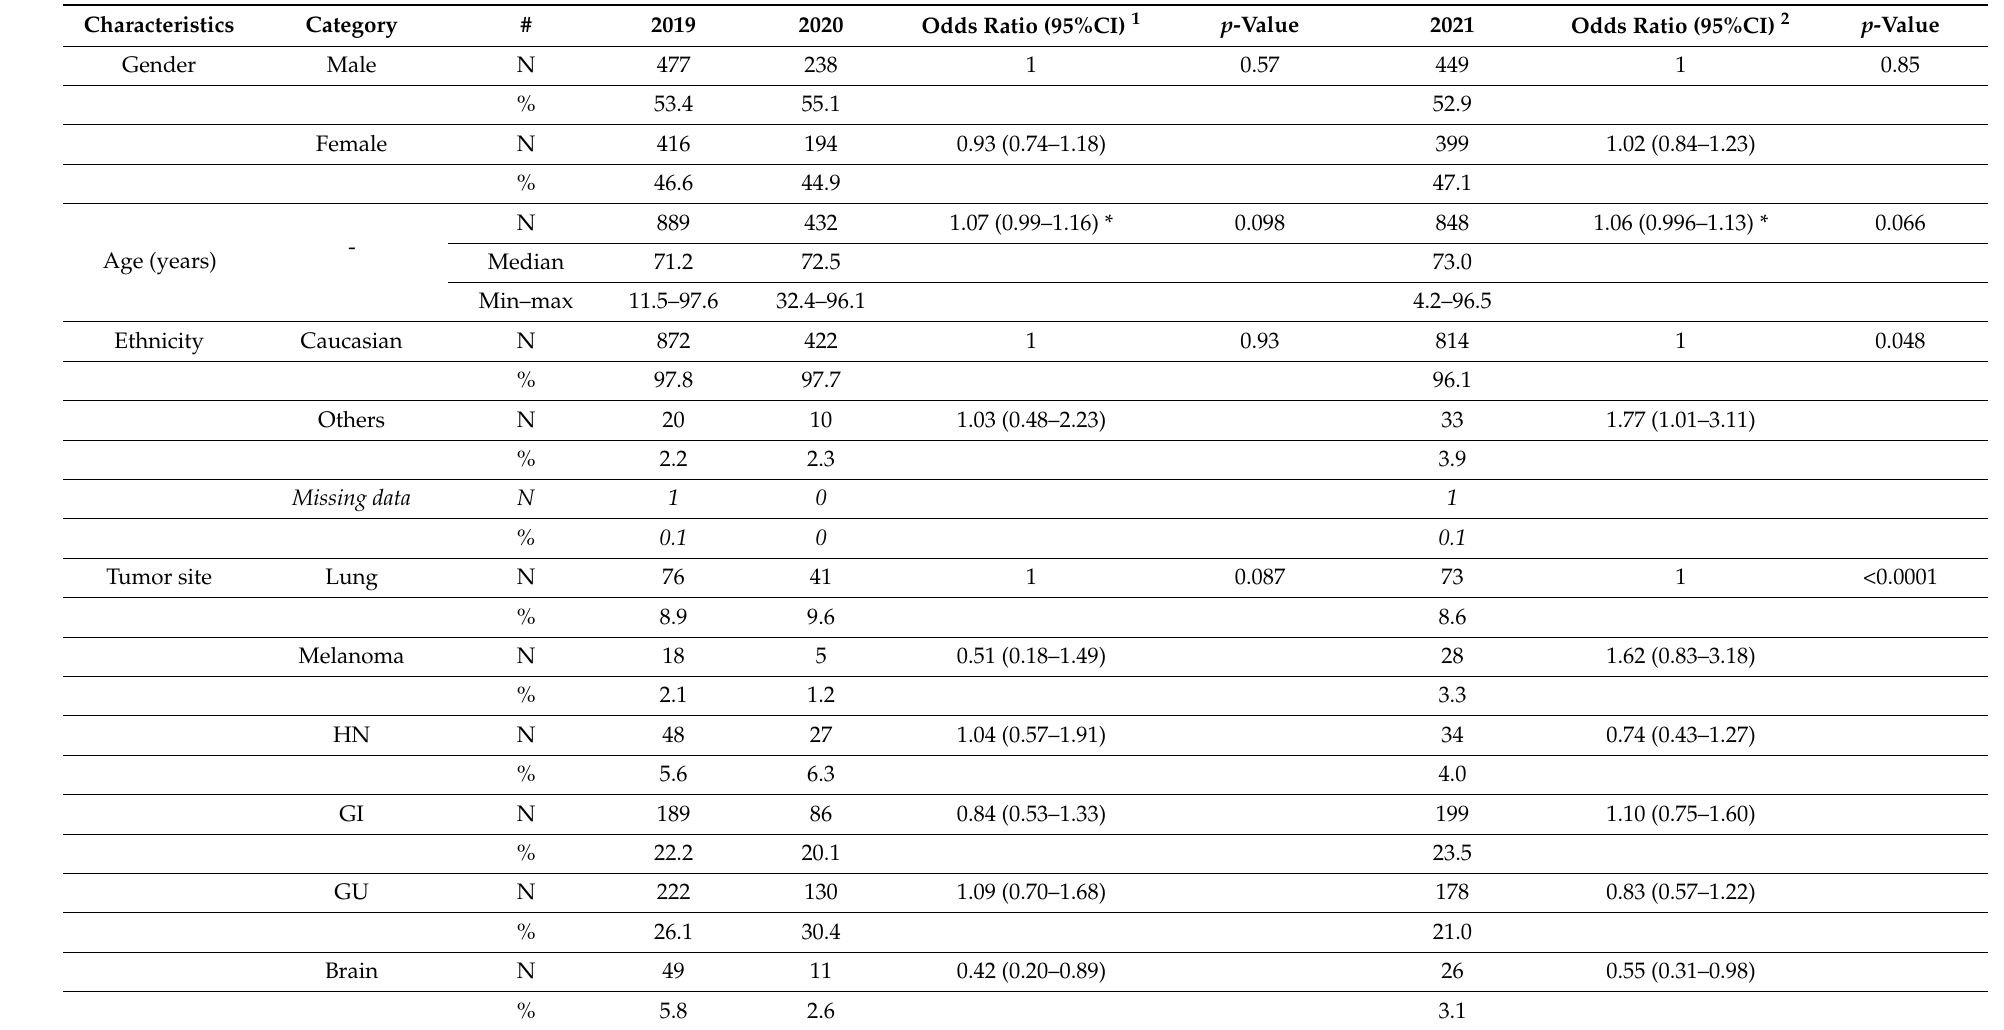
Table 2. Patient’s